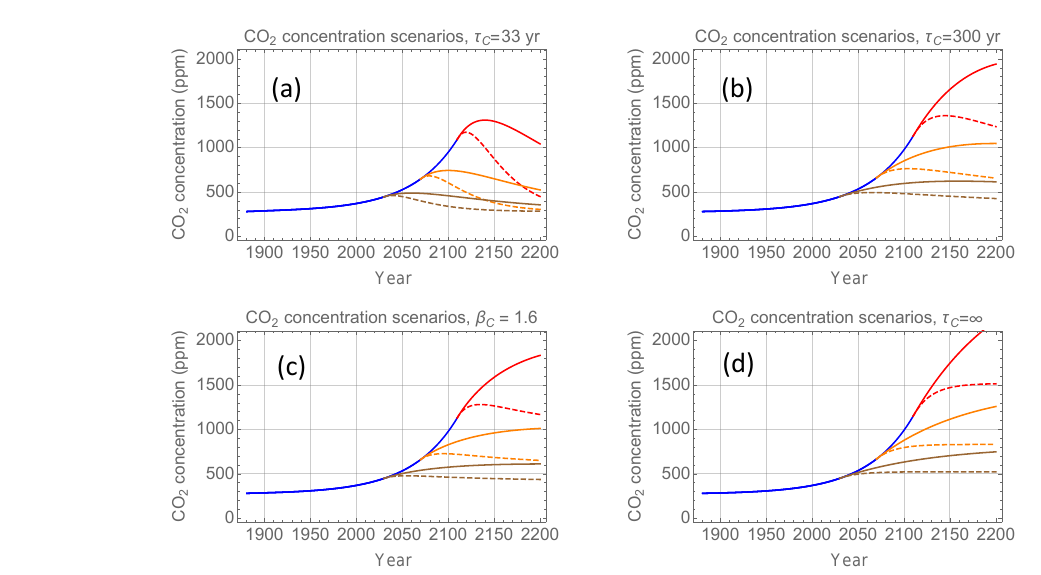
Figure 4. Projections of CO 2 concentration under the emission scenarios in Fig. 3 using the modelling explained in Sect. 2. The colours correspond to those in Fig. 3. Panel (a) : τ C